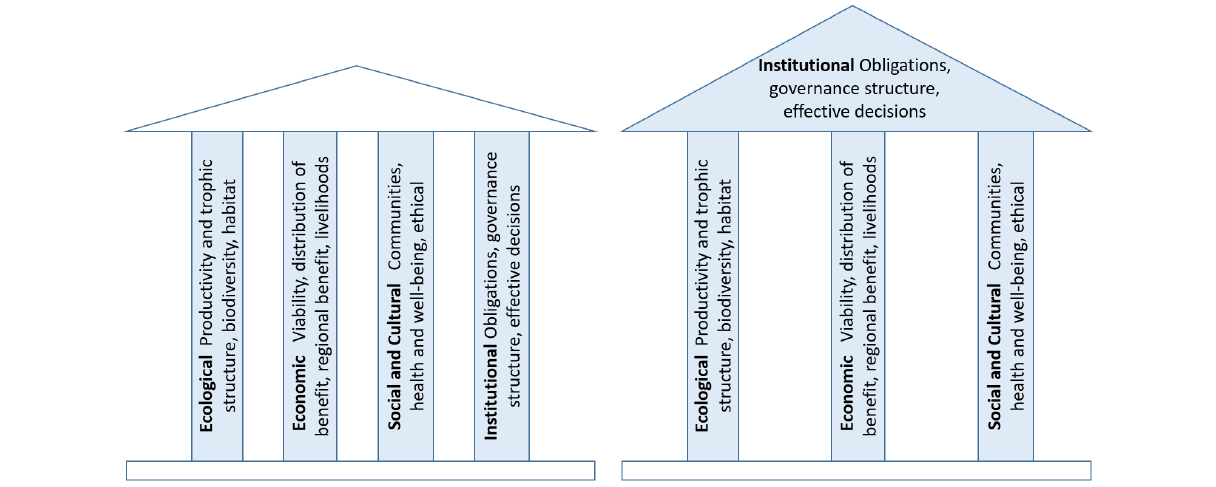
Fig. 1 . Two perspectives on full spectrum